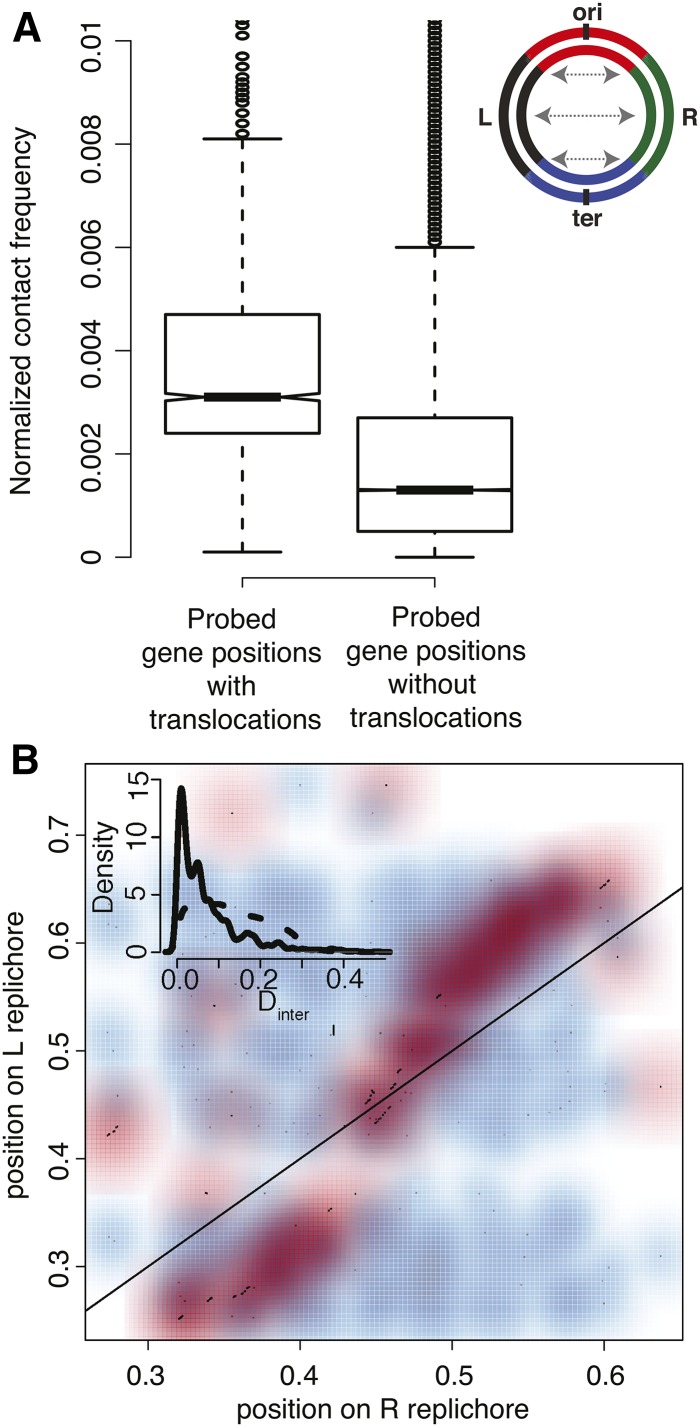
Interreplichore translocations and chromosomal contact points. (A) Boxplot representing the normalized interreplichore contact frequencies as derived from Le et al. (2013) for C. crescentus NA1000 (NC_011916); for all the probed gene positions with or without interreplichore translocations (P-value < 10−10, Wilcoxon test). (B) Scatterplot representing 386 interreplichore (R → L) translocations between C. crescentus NA1000 (NC_011916) and C. segnis (NC_014100) in red and randomized dataset (as described in Materials and Methods) in blue. Inner panel shows the distribution of Dinter = | dRi/Lj – dLi/Rj | (solid line) for interreplichore translocations between C. crescentus NA1000 (NC_011916) and C. segnis (NC_014100). Dashed line indicates distribution of Dinter for randomized data (as described in Materials and Methods).